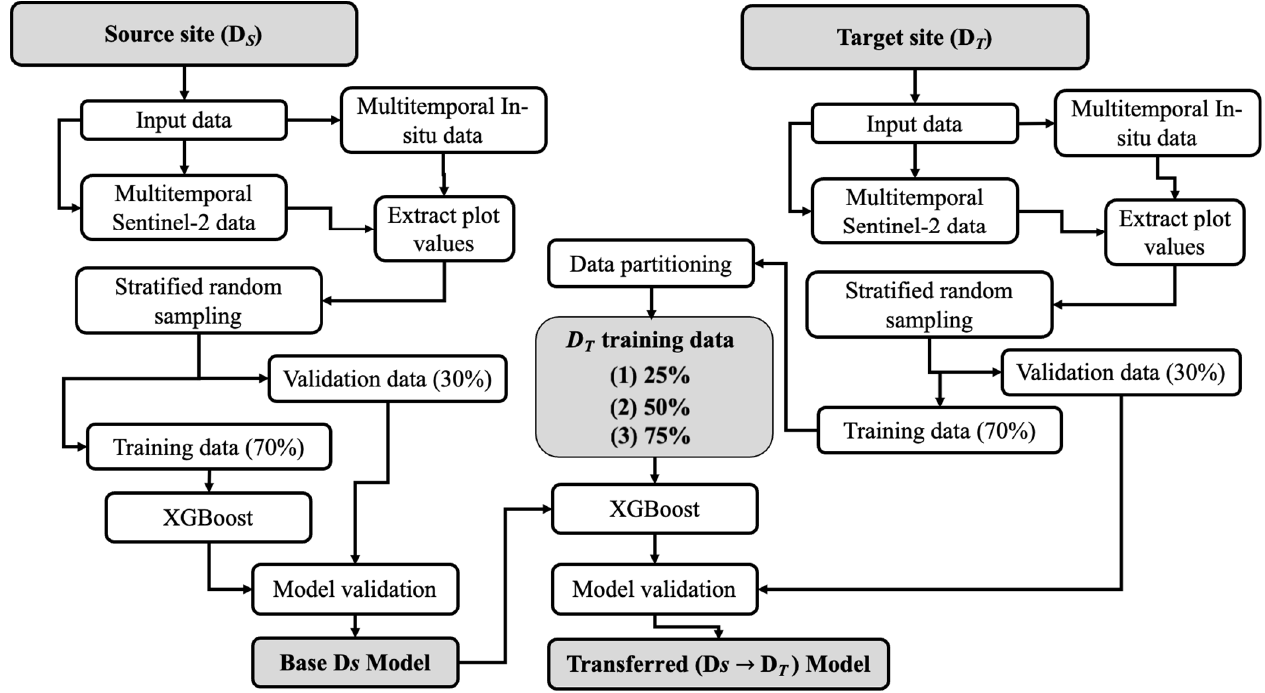
Figure 2. Flowchart summarizing the methodology of the study in a one-directional transfer setting, e.g., Bothaville ( D S ) → Harrismith ( D T